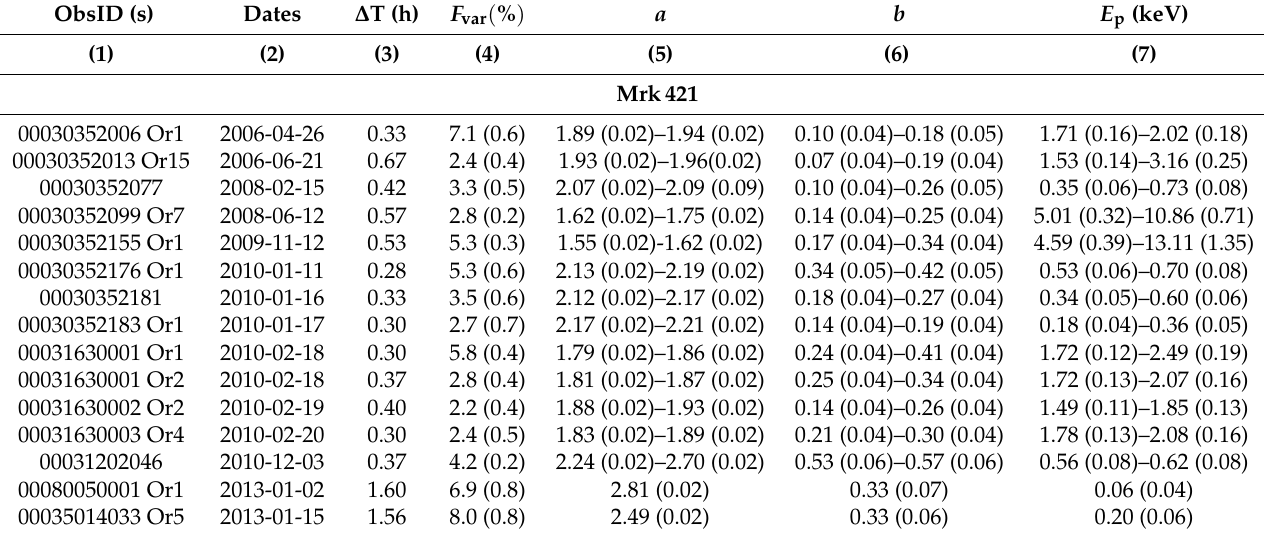
Table 2. Summary of the 0.3–10 keV sub-hour IDVs observed in bright HBLs on timescales longer than 1 ks with Swift-XRT. In Column (1), “Or” stands for “Orbit”. The third column gives the total length of the particular observation; Columns (5)–(7) give the ranges of the photon index, the curvature parameter and the position of the synchrotron SED